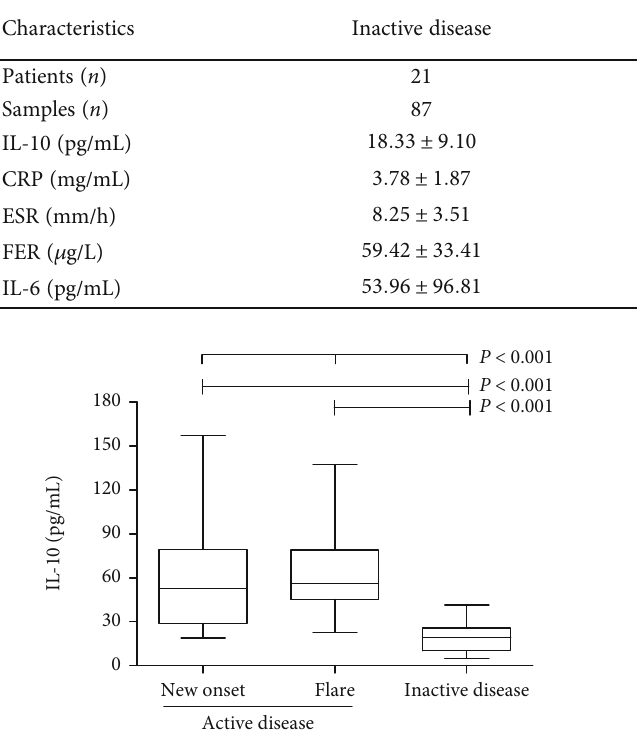
Figure 2: Comparison of serum IL-10 levels among patients with SoJIA with active and inactive disease activity.